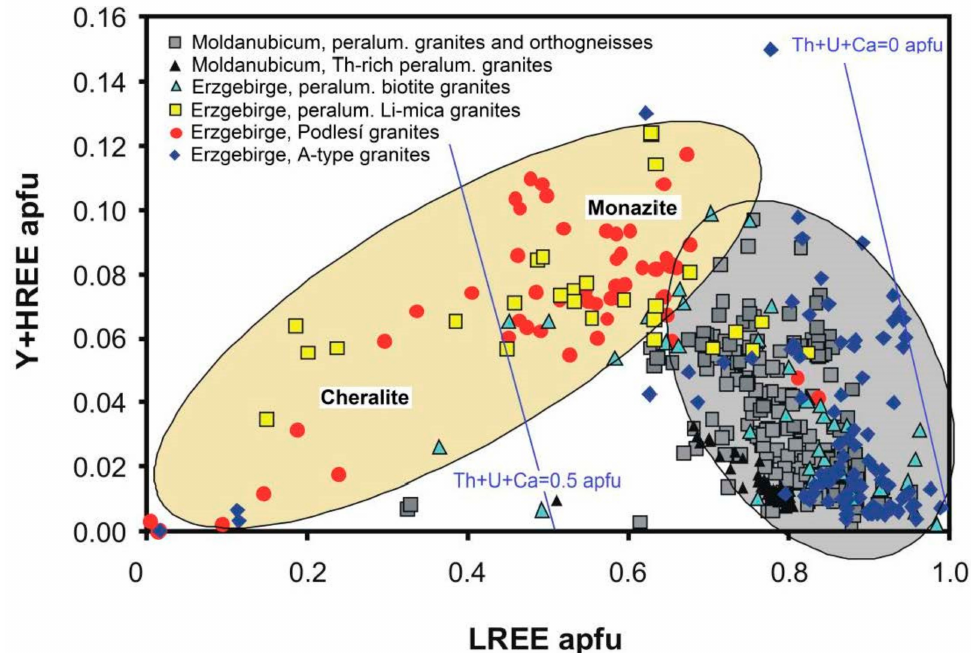
Figure 9. Light rare earth elements (LREE) vs. Y + HREE (heavy rare earth elements) contents in monazite of different origins. Data from the Moldanubicum are taken from [5]. Blue lines visualize identical contents of Th + U + Ca (huttonite + cheralite component). Gray field: Th,U-poor monazite from A-type and less fractionated S-type granites. Beige field: Th, U-rich monazite-cheralite s.s. from fractionated S-type